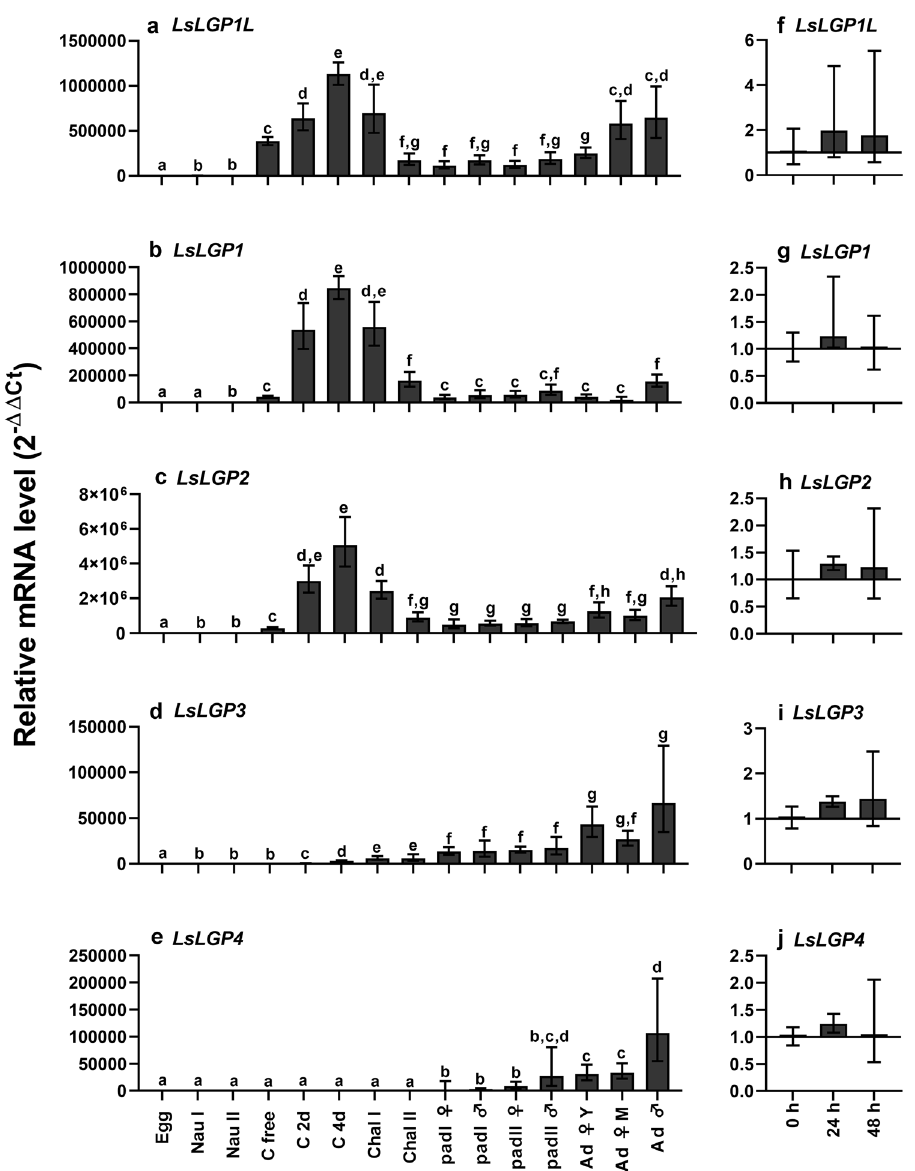
Figure 3. Level of L. salmonis labial gland protein ( LsLGP ) transcripts during development and starvation related to the LsEF1α and LsADT3 reference genes (N = 5). ( a–e ) Developmental expression in fertilized egg sacs (egg), nauplius (nau) I and II, planktonic copepodids (c free) and copepodids 2 days (c 2d) and 4 days (c 4d) post infestation, chalimus (chal) I and II, pre-adult (pad) I and II and adult lice (ad). For female adult lice both young (Y) and mature (M) lice were analyzed. mRNA level was related to that of fertilized egg sacs. Statistically significant differences are denoted with different letters (p ≥ 0.05). ( f–j ) Expression in adult females at 0, 24 and 48 h ( h ) after removal from salmon. mRNA levels were related to that of the lice taken directly off the host (0